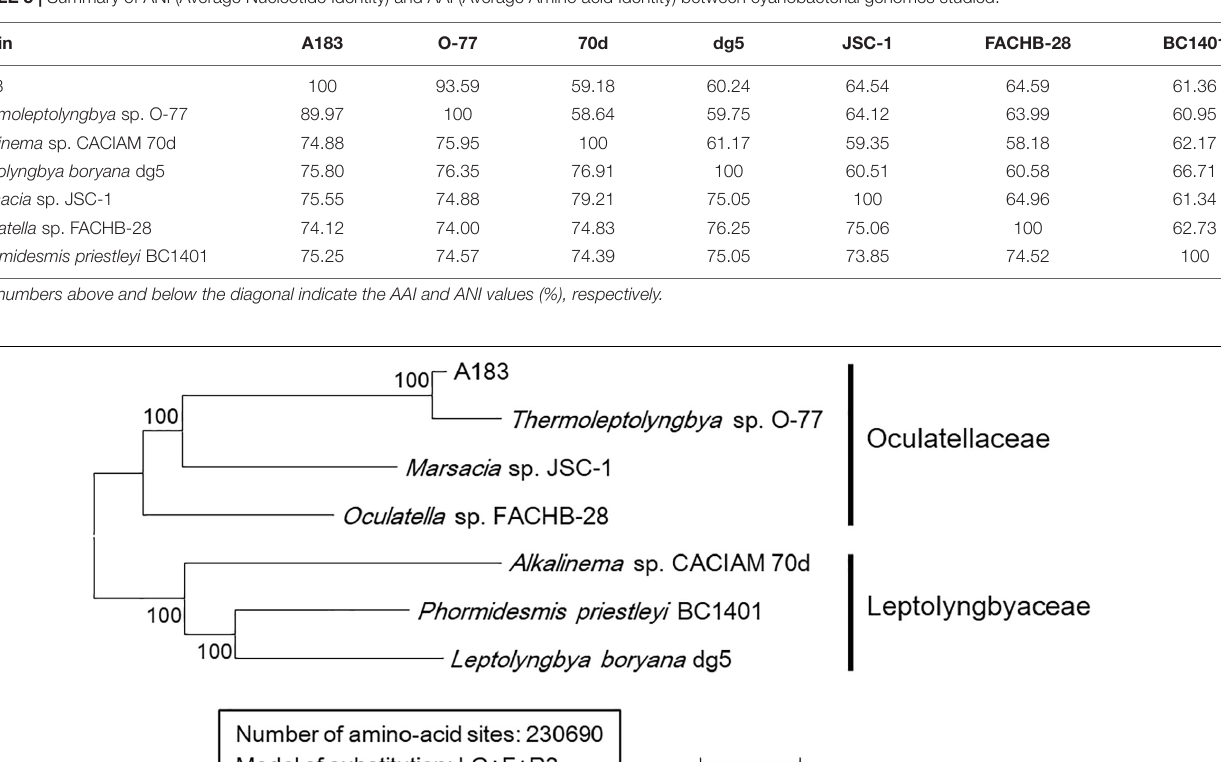
TABLE 5 | Summary of ANI (Average Nucleotide Identity) and AAI (Average Amino acid Identity) between cyanobacterial genomes studied. Strain